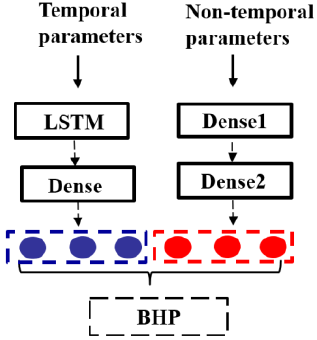
Figure 5. CNN-LSTM parallel network structure.